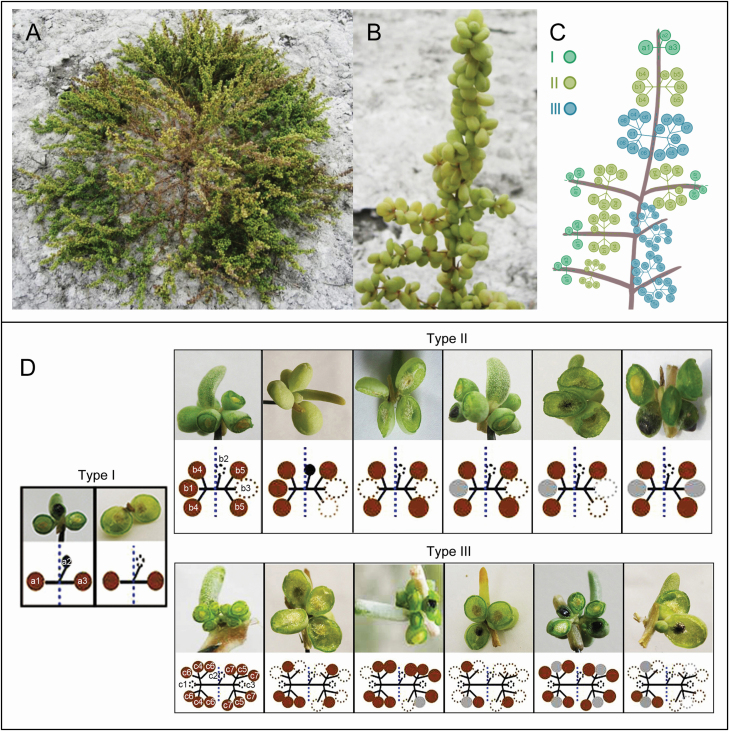
Morphology and schematic diagram of different seed-setting patterns (SSP) in S. aralocaspica. A: a fully developed plant in fruiting stage in natural habitat; B: fruit branch; C: illustration of three types of SPP on the fruit branch; D: the SSP on different dichasium inflorescences, the upper panel in each type shows samples collected from the natural habitat; the lower panel shows the schematic diagram of SSP corresponding to Fig. 1. Type I, II, III: corresponding to I, II, III in Fig. 1. Blue dashed line represents inflorescence axis; black solid line represents fruit stalk; black solid circle represents small black seed; brown solid circle represents brown seed; gray solid circle represents large black seed; dotted open circle represents a probable setting seed or shed seed.